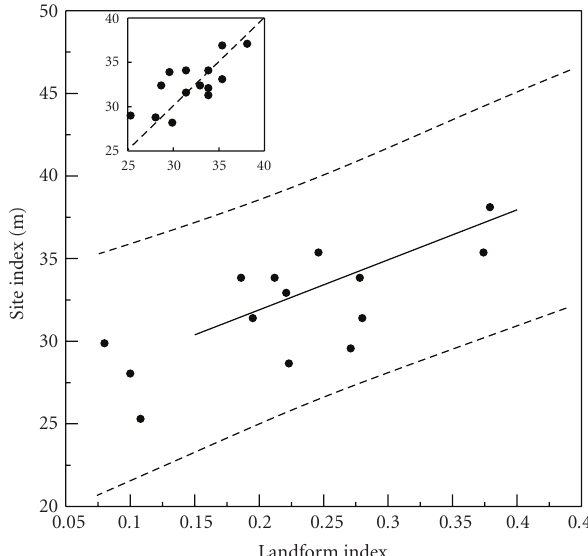
Figure 3: Observed site index for yellow-poplar from the 14 stands sampled in this study was within the 95% confidence limits (two dashed lines) for individual predictions from a model (solid line) reported in a previous study [9] conducted throughout the Southern Appalachian Mountains (SAM). The length of the solid line indicates the range of landform index (0.15 to 0.40) used in development of the SAM model. The inset shows the significant relationship ( r = 0 . 72, P < . 01) between yellow-poplar site index observed in this study ( x -axis) and site index predicted by the SAM model ( y -axis). The diagonal dashed line in the inset represents perfect correlation between observed site index and site index predicted by the SAM